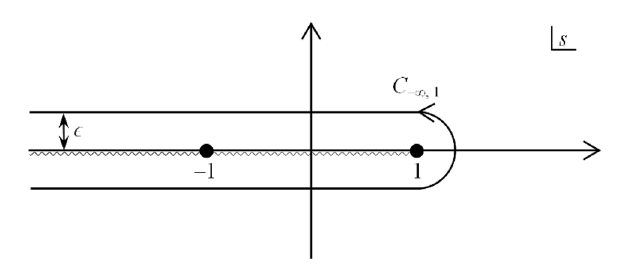
Figure 2 . The contour around ( (cid:0)1 ;